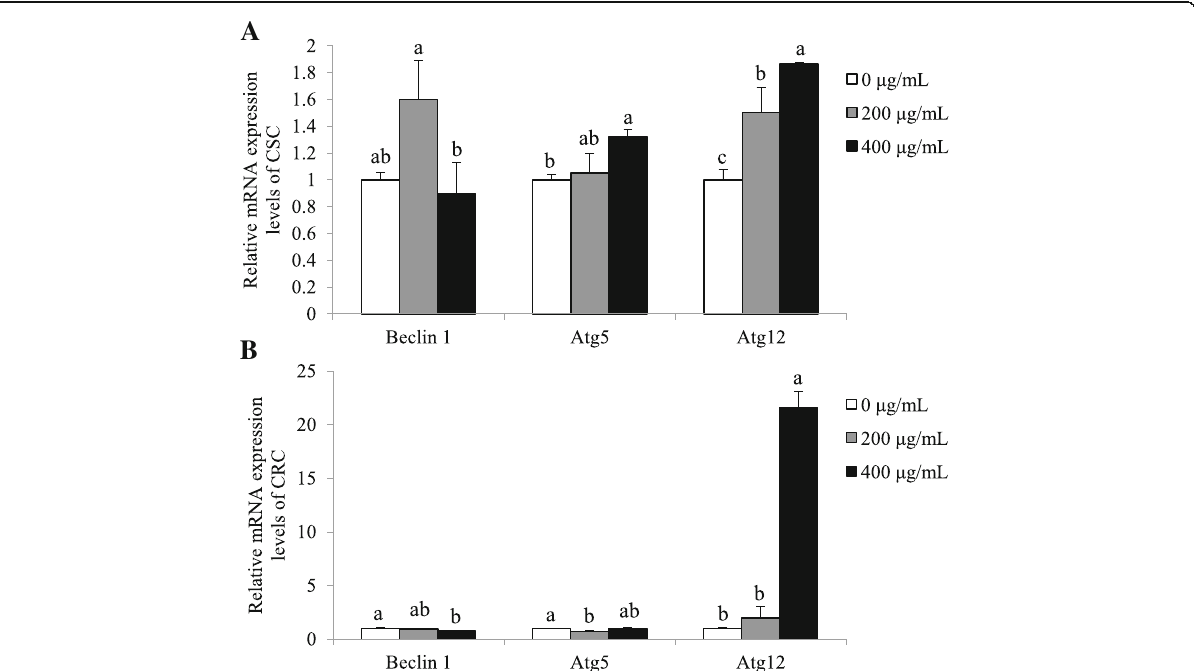
Fig. 5 Effects of of SbE on mRNA expression levels of Beclin 1 , Atg5 , and Atg12 in CSC and CRC. After cells were exposed 200 ~ 400 μ g/mL of SbE for 24 h, mRNA expression levels of ( a ) Beclin 1 , Atg5 , and Atg12 in CSC and ( b ) Beclin 1 , Atg5 , and Atg12 in CRC were quantified by qPCR. All mRNA expression levels were normalized against TBP . Each value is the mean ± SD. p < 0.05 was taken to define statistical significance. One-way ANOVA followed by Duncan post hoc test